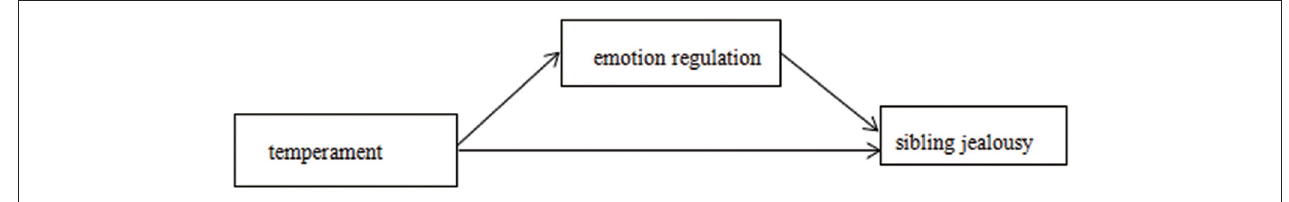
FIGURE 1 | The proposed mediation